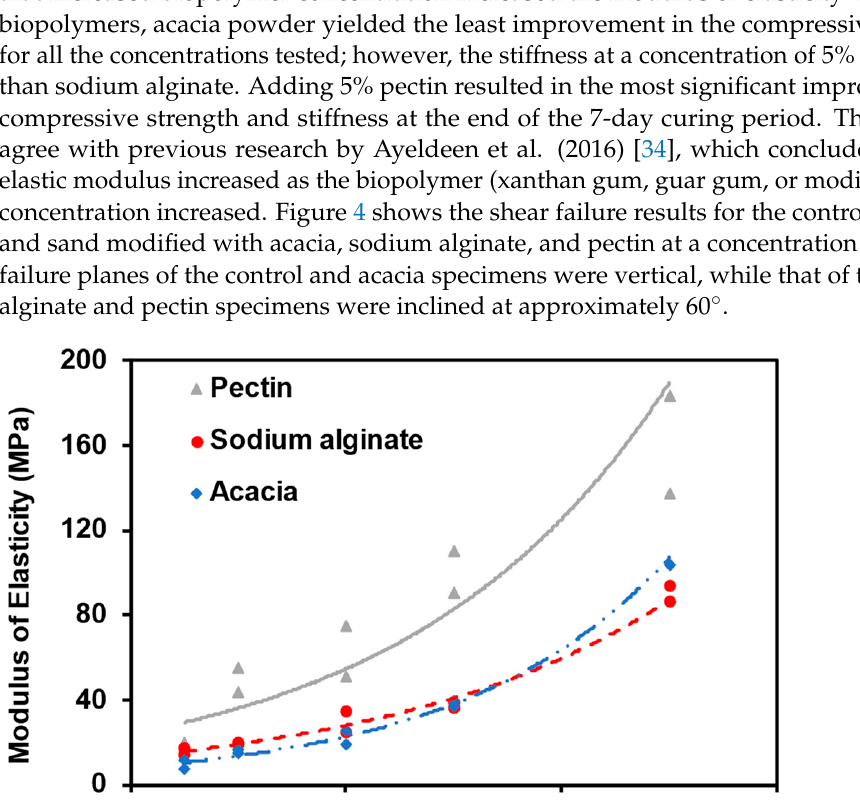
Figure 4. Failure planes for ( a ) control, ( b ) 5% Acacia, ( c ) 5% Sodium alginate, and ( d ) 5% Pectin, after a curing period of seven days . 3.2. Effect of Curing Intervals The impact of varying curing time over 0, 1, 3, 7, 14, 21, 28, and 56 days was examined on the UCS of the biopolymer ‐ modified sand at a room temperature of 25 °C. Since the UCS of the modified sand increases continually with the biopolymer concentration, a con ‐ centration of 2% was selected to study the effect of the curing time of the UCS. Figure 5 presents the influence of curing time on the UCS of sand modified with acacia, sodium alginate, and pectin biopolymer. When the modified sand was not allowed to cure and was tested immediately after preparation, a low UCS of 9.18 kPa, 12.11 kPa, and 9.66 kPa were obtained for acacia, sodium alginate, and pectin, respectively. The strength of the biopolymer ‐ modified sand increased significantly after one day of curing to 142.31 kPa, 102.32 kPa, and 149.33 kPa for acacia, sodium alginate, and pectin, respectively. The re ‐ sults indicate that the curing time is an essential parameter for the strength development of biopolymer ‐ modified sand.